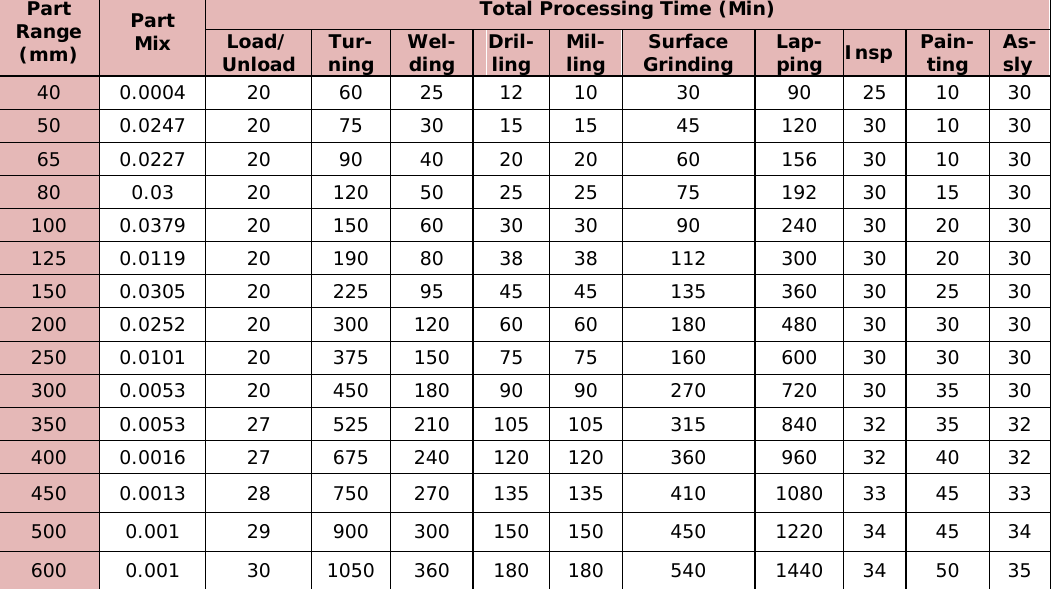
Table 1a. “Dual Plate Check Valve”. Source: Own